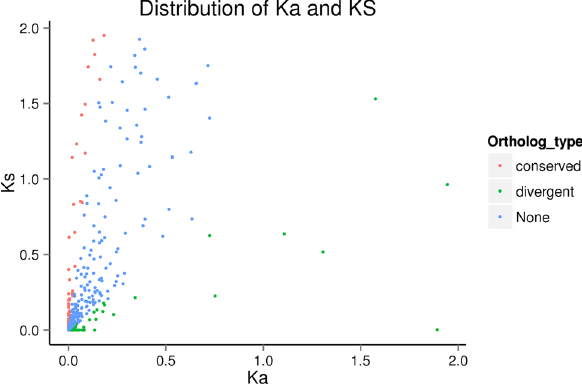
Figure 3. Orthologous distribution of Ka and Ks distribution.